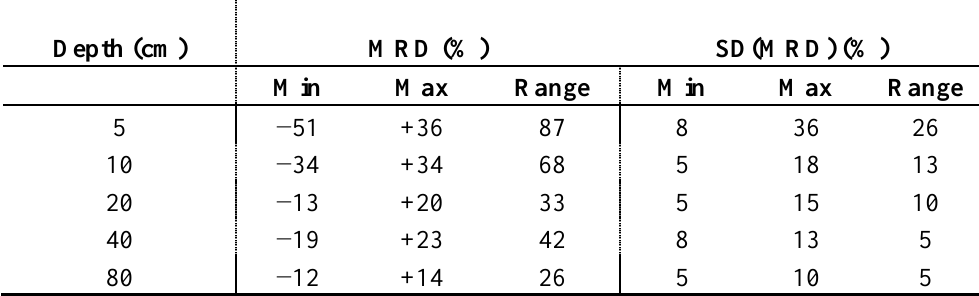
Table 2. Minimum (Min) and Maximum (Max) values of MRD and SD(MRD) at 5, 10, 20, 40, 80 cm depth at the Maqu network